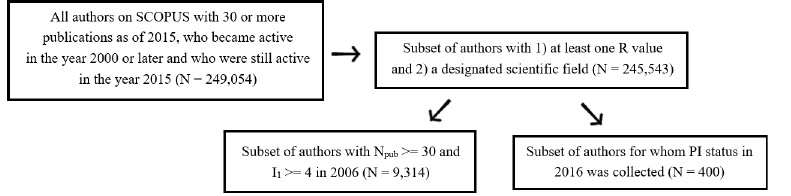
Fig 1. Data collection flowchart for this study. “N pub ” is the total number of publications of that author.